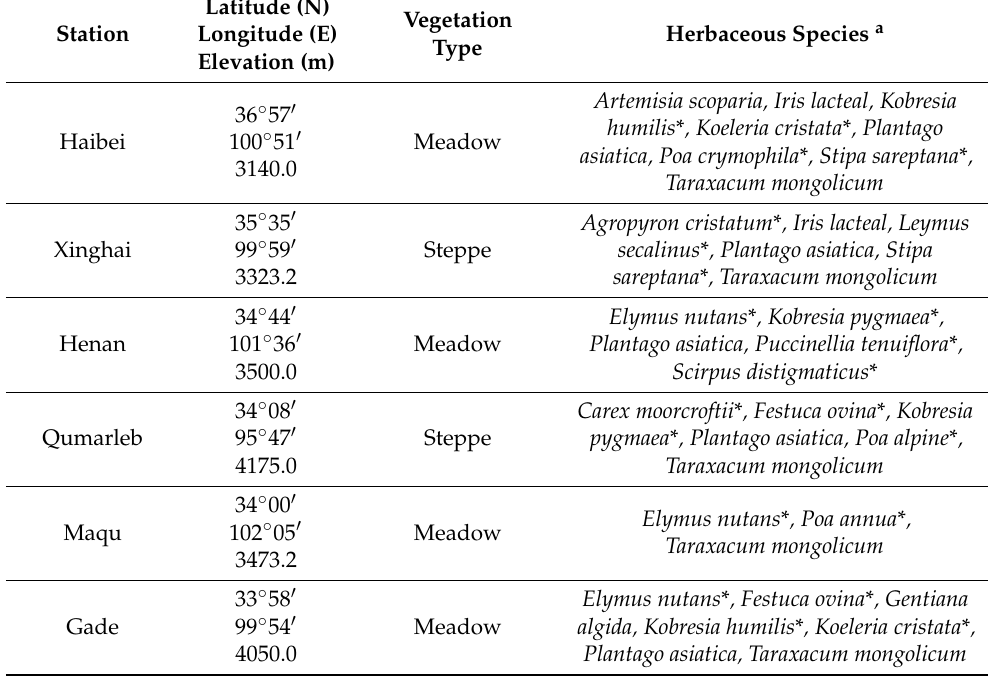
Table 1. The general information and observed herb species in phenological